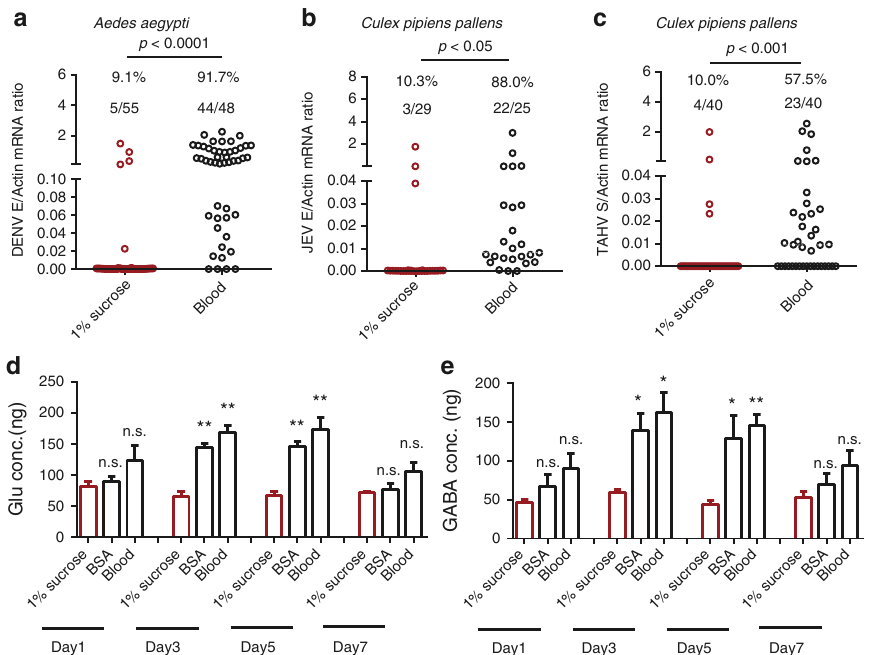
Fig. 5 Glutamate-mediated GABA induction by blood ingestion. a – c Feeding blood enhanced the infection of DENV-2 in A. aegypti a , JEV in C. pipiens pallens b and TAHV in C. pipiens pallens c . Either human blood or 1% sucrose (500 µ l) was premixed with supernatant from 6 × 10 5 p.f.u./ml of DENV-2-infected a , 5 × 10 5 p.f.u./ml of JEV-infected b or 5 × 10 6 p.f.u./ml of TAHV-infected c Vero cells (cultured in serum-free medium) (500 µ l) to feed mosquitoes via an in vitro membrane blood meal. Mosquito infectivity was determined by TaqMan qPCR at 8 days post-blood meal. The number of infected mosquitoes relative to the total number of mosquitoes is shown at the top of each column. Each dot represents one mosquito. The data upper mosquito number are represented as the percentage of mosquito infection. Differences in the mosquito infective ratios were compared using Fisher ’ s exact test. d and e Protein ingestion augmented the amount of glutamic acid d and GABA e in the mosquitoes over time after a meal. Either whole human blood or 70 mg/ml BSA was used for oral feeding of A. aegypti . Mosquitoes fed 1% sucrose served as negative controls. The fed mosquitoes were collected over time after feeding and were used to assess the amounts of glutamic acid and GABA present. The numbers on the Y -axis represents the amount of GABA inoculated per mosquito. The data are presented as the mean ± S.E.M. Differences were considered signi fi cant if P < 0.05. * P < 0.05; ** P < 0.01; and *** P < 0.001. The data were analyzed statistically using the non-parametric Mann – Whitney test. The results were reproduced twice. a – e The data from at least